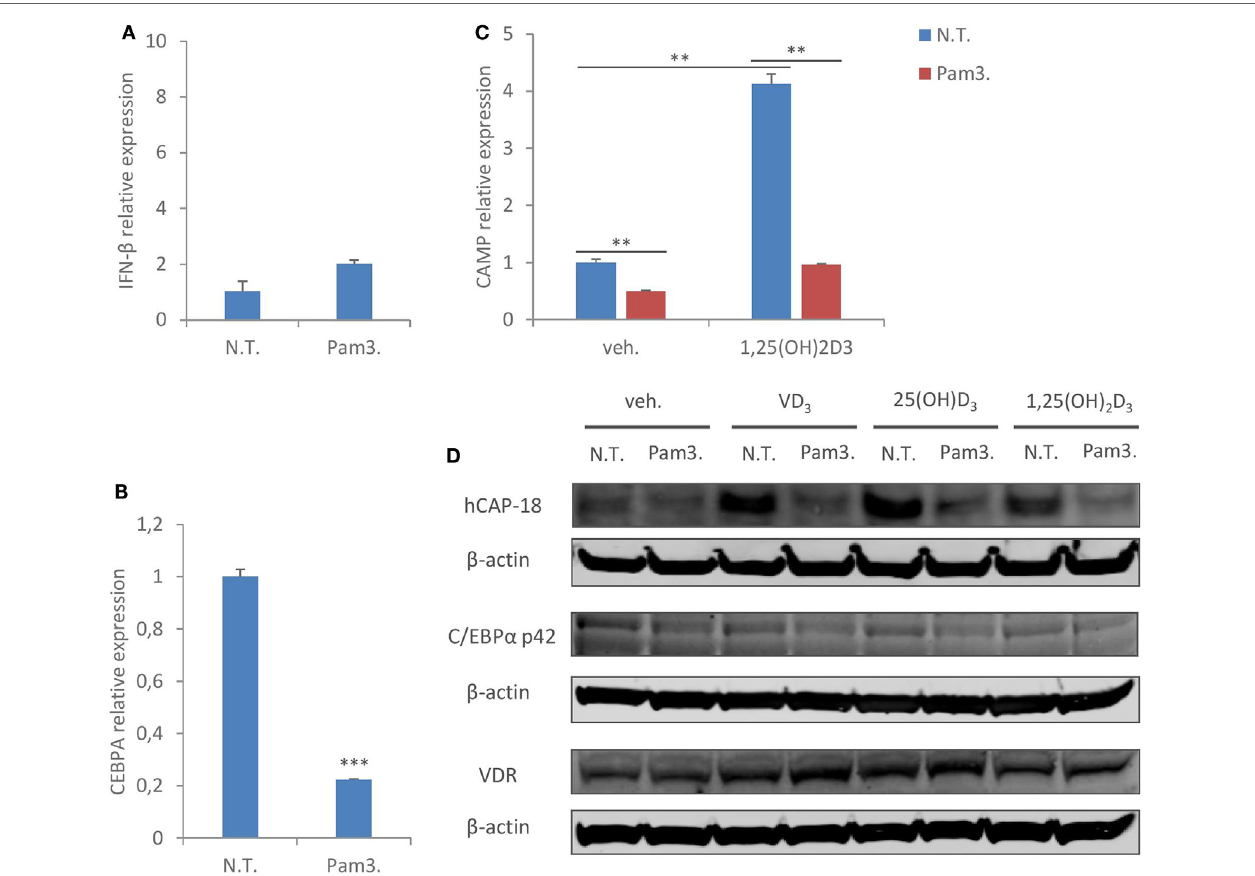
FigUre 6 | TLR1/2 ligand treatment reproduces the same suppressive effect on C/EBP α and cathelicidin antimicriobial peptide (CAMP) in human macrophages. (a,B) Monocyte­derived macrophages (MDMs) were non­treated (N.T.) or treated with TLR1/2 ligand Pam3CSK4 (Pam3.) for 24 h. IFN­ β (a) and C/EBP α (CEBPA) (B) mRNA expression was assessed by quantitative real­time PCR (qRT­PCR). (c) MDMs were non­treated (N.T.) or treated with Pam3CSK4 for 24 h in the presence or absence of 1,25(OH) 2 D 3 . mRNA expression of CAMP was assessed by qRT­PCR. (D) MDMs were non­treated (N.T.) or treated with Pam3CSK4 for 24 h in the presence or absence of different forms of vitamin D. CAMP (hCAP­18), C/EBP α (p42), and vitamin D receptor (VDR) protein expression was assessed by immunoblotting. Error bars represent SD for triplicates. ** p < 0.01, *** p < 0.001. Data are representative of at least three independent experiments from different donors. Full­length blots are presented in Figure S1 in Supplementary